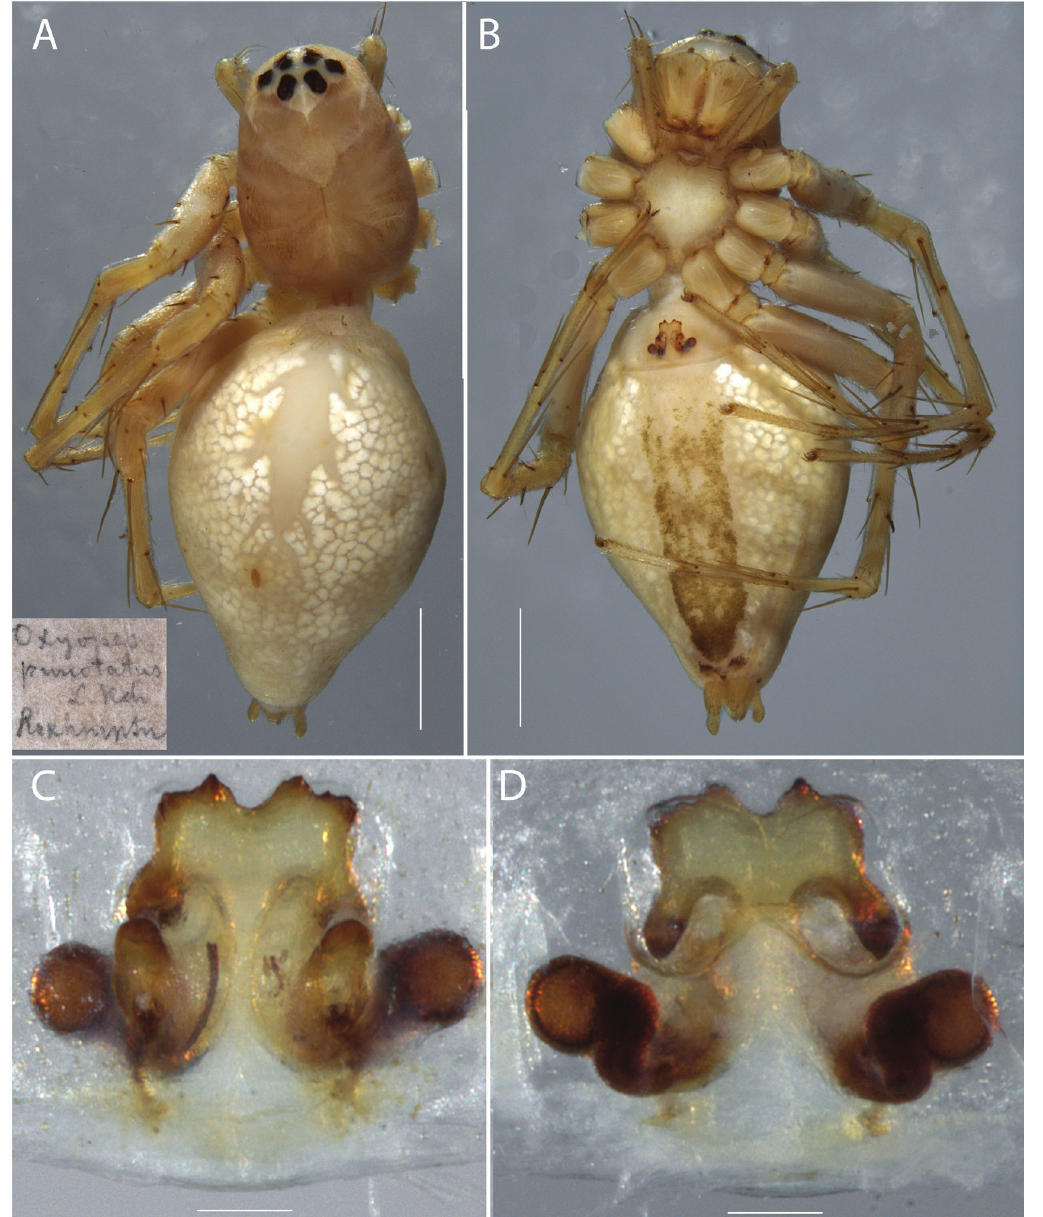
Figure 14. Oxyopes punctatus L. Koch, 1878, female syntype ( ZMH- A0000016): A , habitus, dorsal view; B , habitus, ventral view; C , epigyne, ventral view, cleared; D , epigyne, dorsal view, cleared. Scale bars: habitus 1.0 mm, epigyne 0.1 mm.